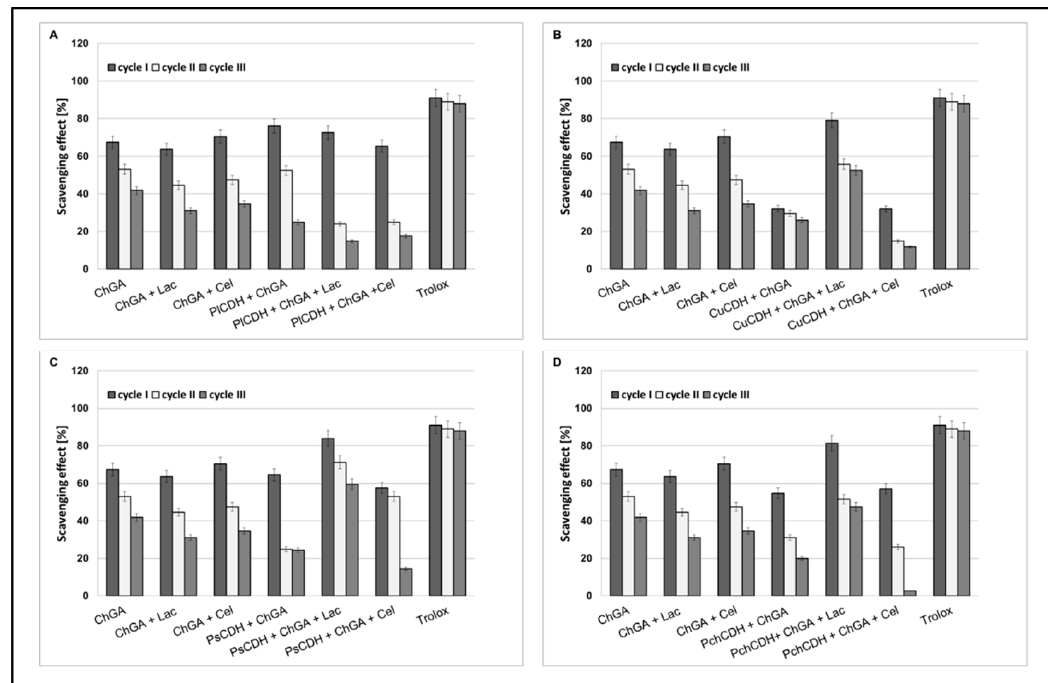
Figure 5. Operational stability of chitosan beads with glutaraldehyde (ChGA) (C1-control) with lactose, ChGA + Lac (C2-control), or cellobiose ChGA + Cel, (C3-control) containing CDHs isolated from Phlebia lindtneri (Pl CDH) ( A ), Cerrena unicolor (Cu CDH) ( B ), Pycnoporus sanguineus ( Ps CDH) ( C ) and Phanerochaete chrysosporium (Pch CDH) ( D ). Data are mean ± SD for three measurements (n = 3).